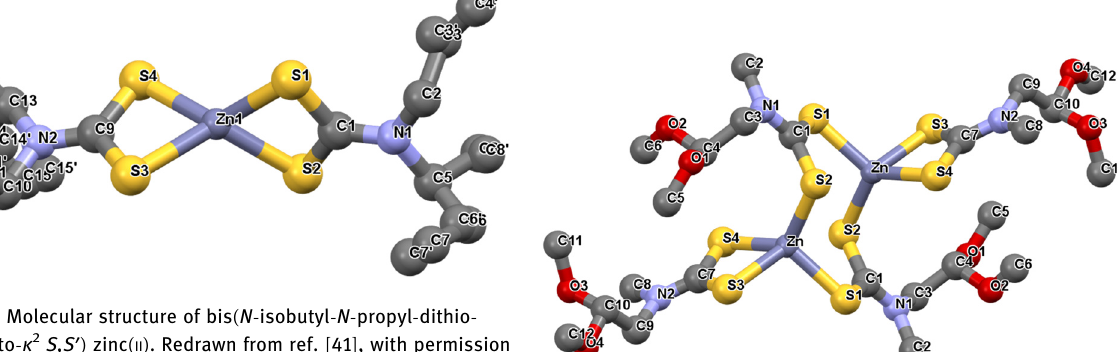
Figure 4: Molecular structure of bis ( N - isobutyl - N - propyl - dithio - carbamato - κ 2 S,S ′ ) zinc ( II ) . Redrawn from ref. [ 41 ] , with permission of the “ International Union of Crystallography ” ( Copyright 2020 ) .